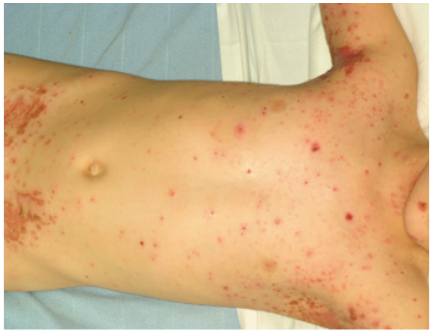
Figure 1: Widespread erythematous papular rash.